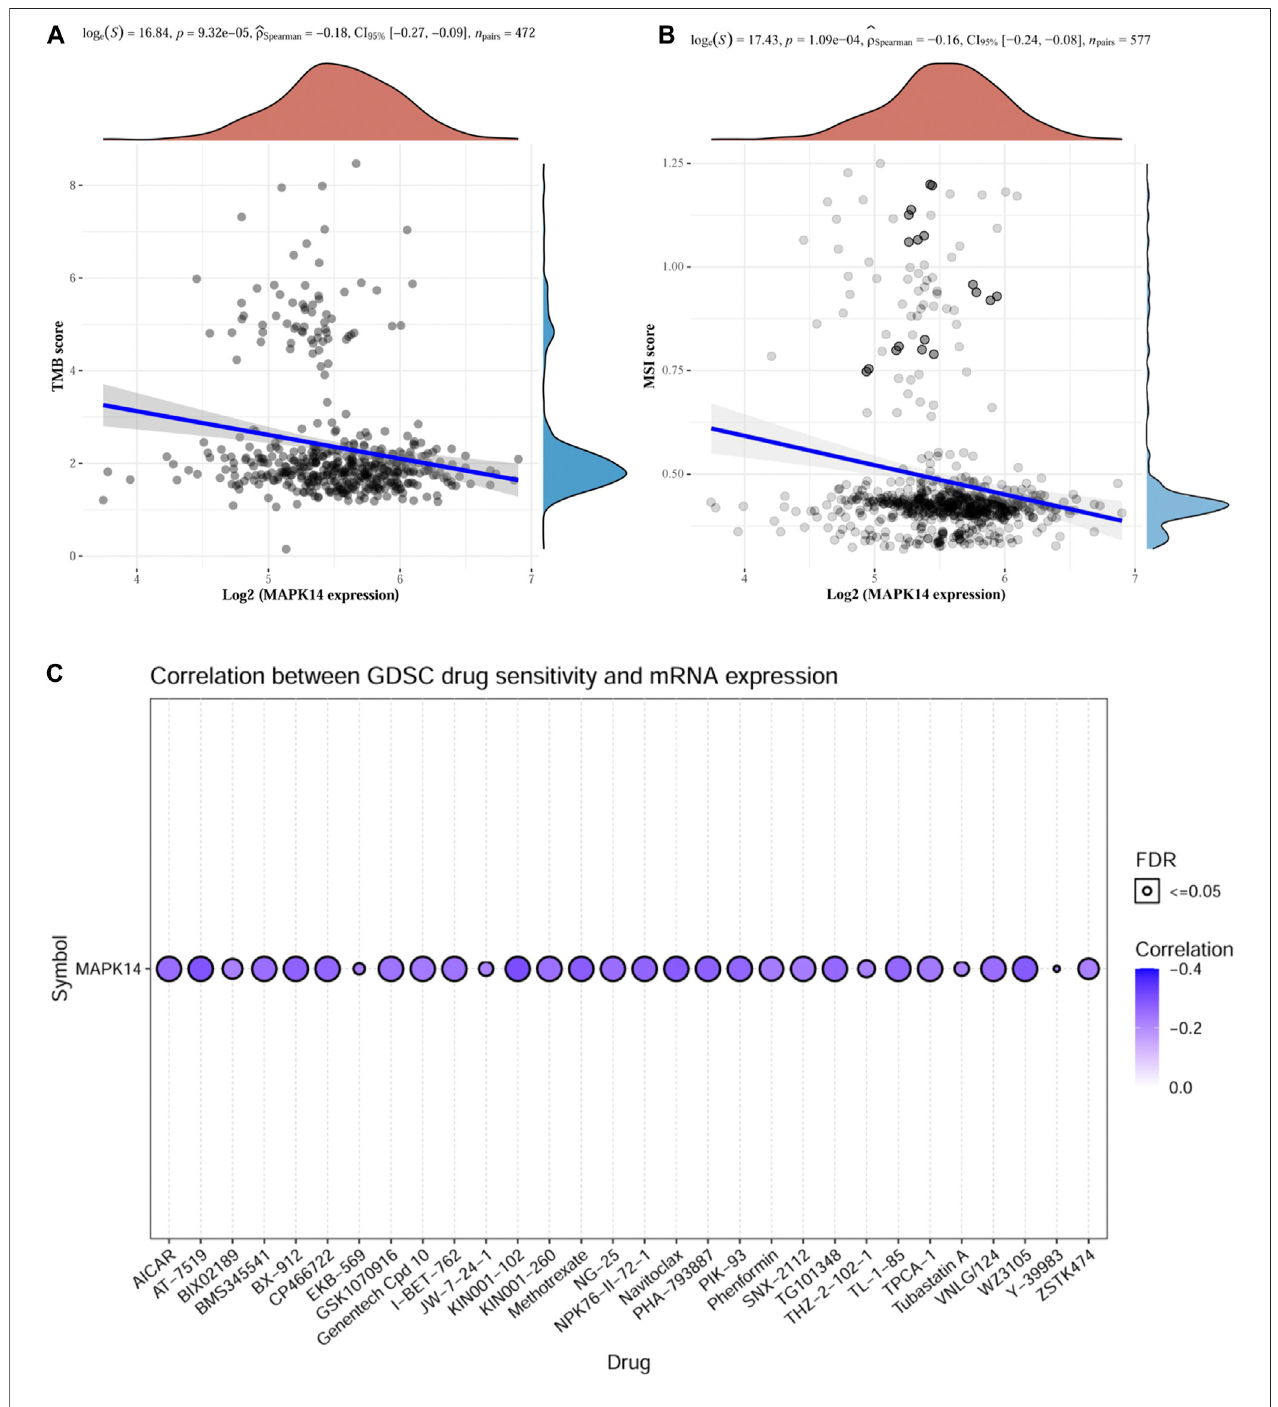
FIGURE8| TMB,MSIanddrugsensitivity analysesofMapk14inCRC. (A) CorrelationbetweenMapk14andTMBinCRC. (B) Correlation betweenCRCandMSI. (C) Correlation between Mapk14 and CTRP drug sensitivity.